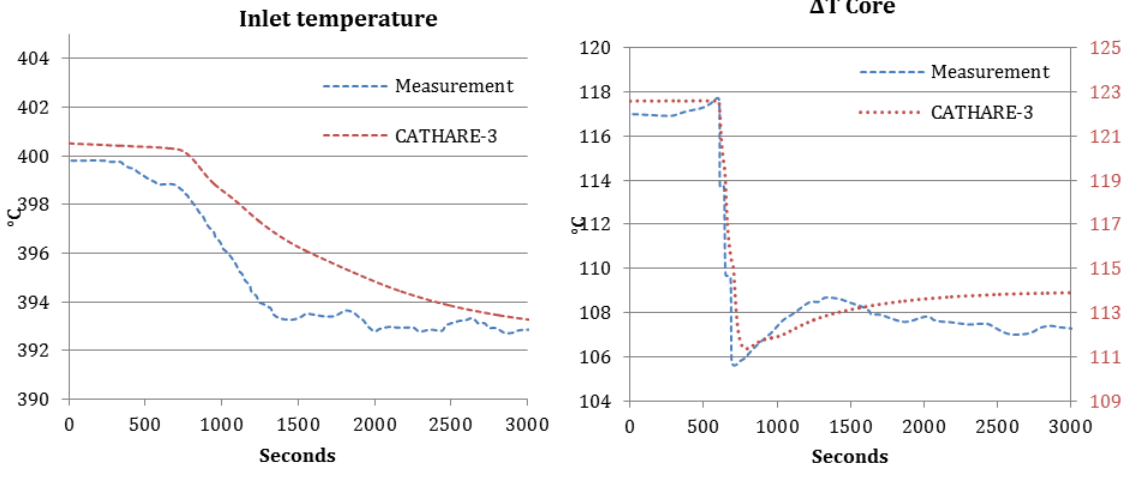
Figure 5. Inlet temperature (left) and ΔT Core (right) during the NRI